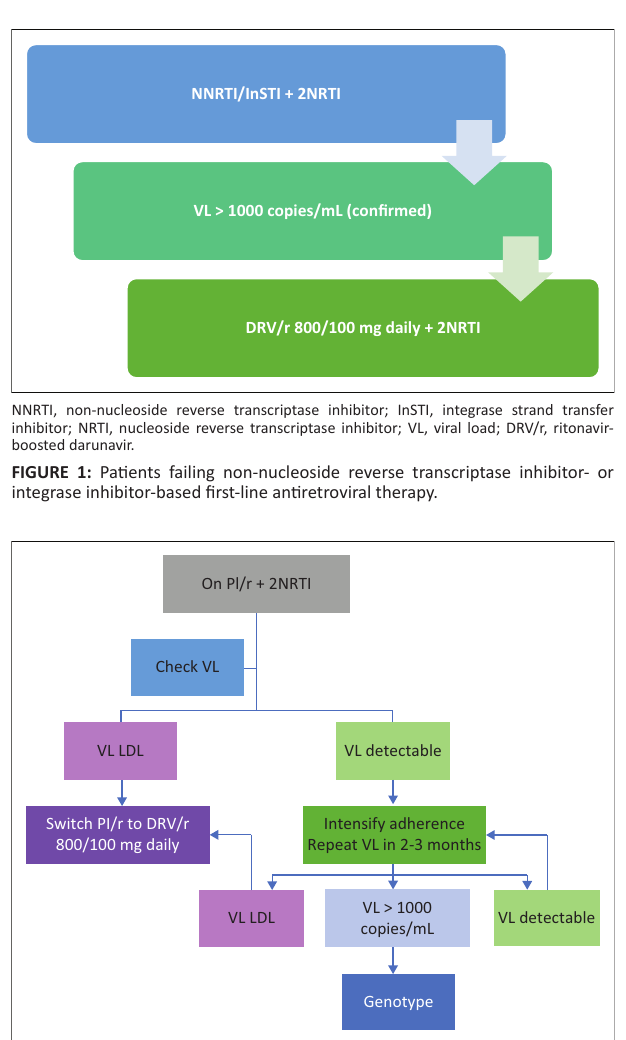
FIGURE 4: Third-line patients on darunavir/ritonavir-based third-line antiretroviral therapy (600/100 mg bid).